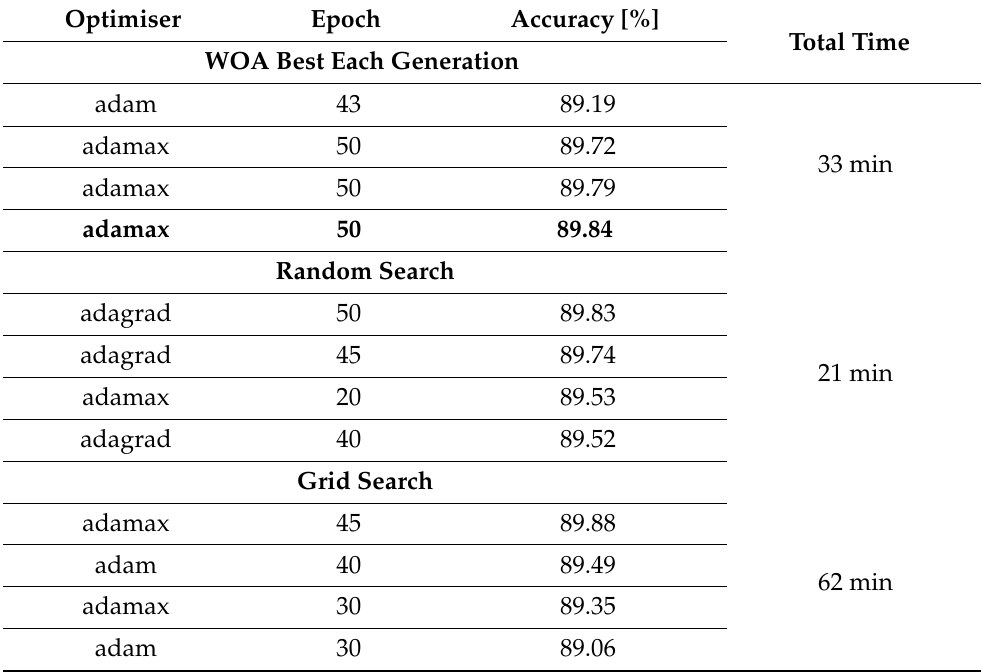
Table 2. Fashion MNIST, epoch (0–50), discrete optimiser, batch